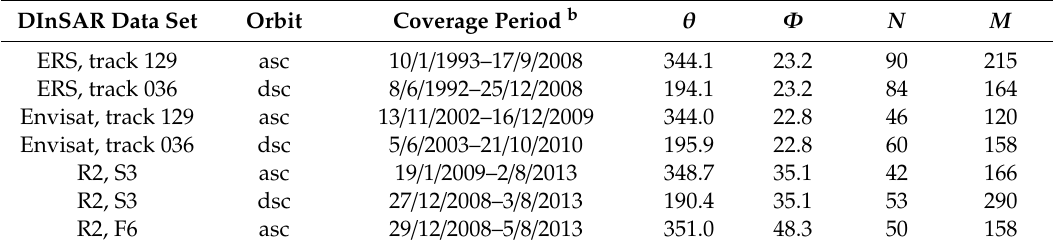
Table 1. Seven DInSAR data sets used in this study with continuous coverage from 1993 until 2013 a [53]. DInSAR Data